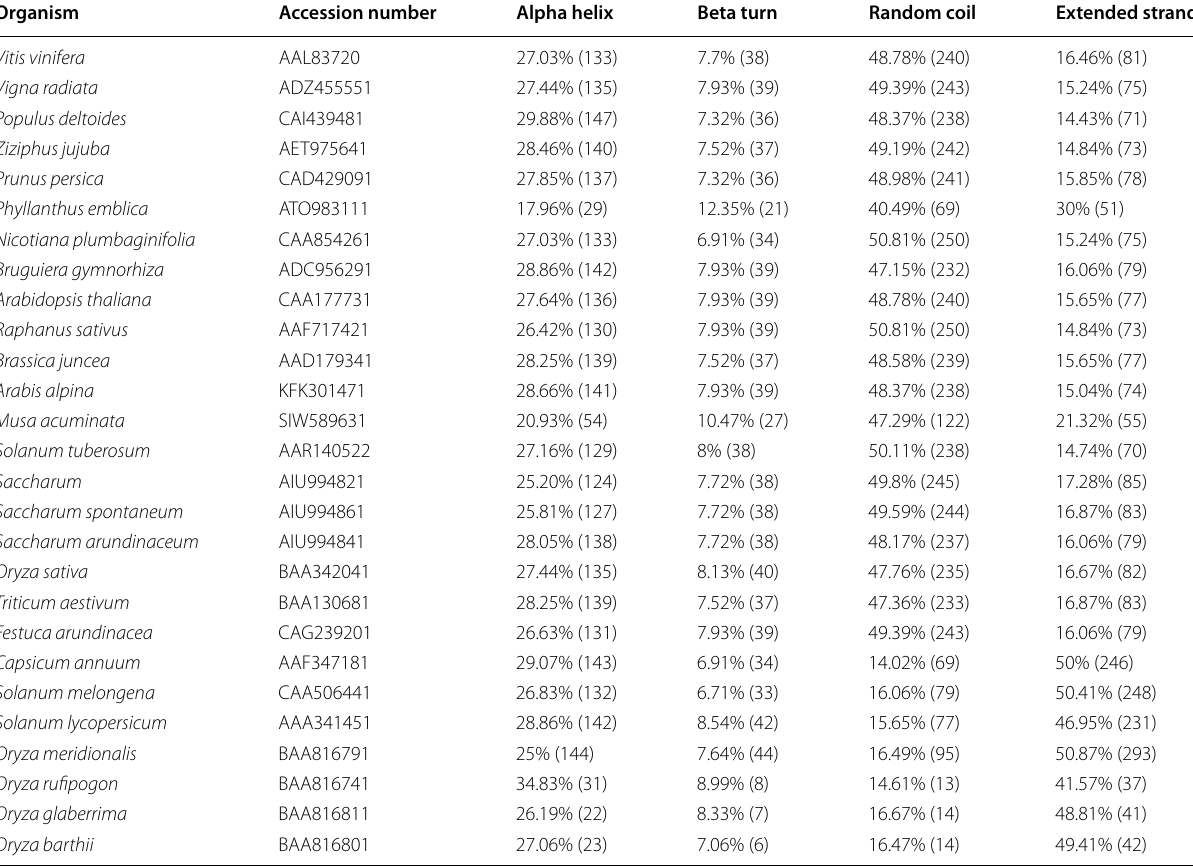
Table 5 Secondary structure prediction of plant catalases using